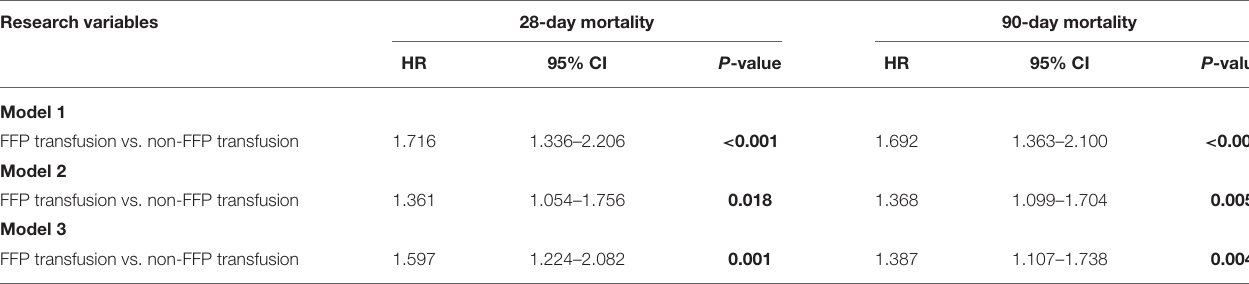
TABLE 3 | A multivariate Cox regression analysis of 28- and 90-day mortality.